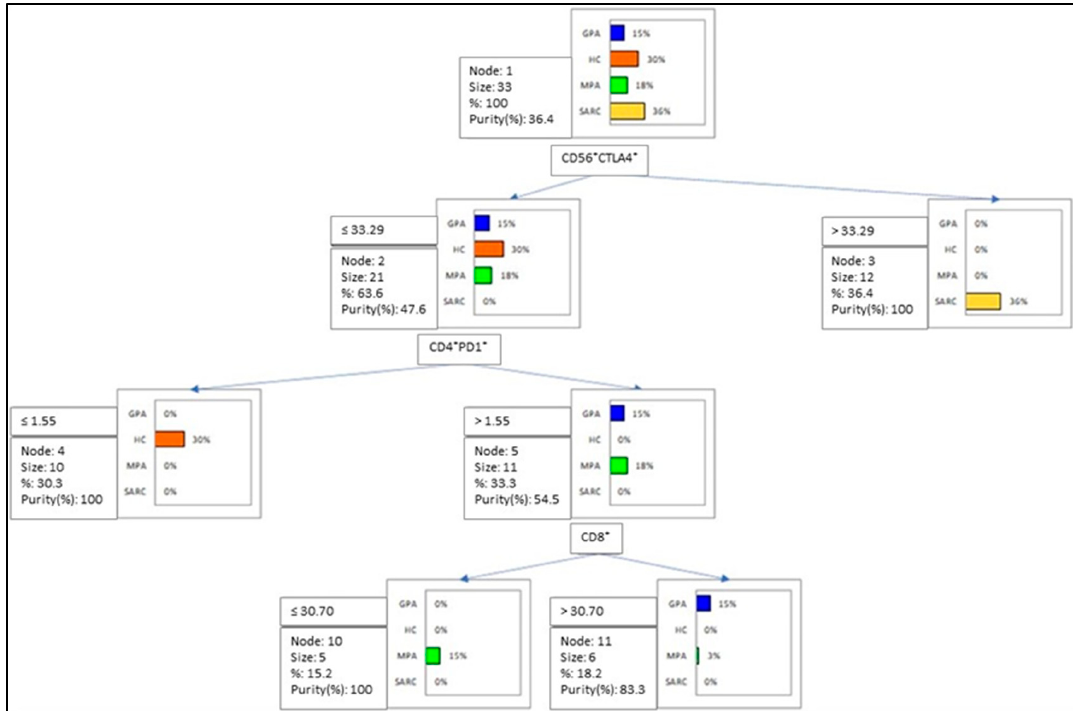
Figure 3. The decision tree model used to cluster the MPA, GPA, sarcoidosis and HC groups ac- cording to cut-off values of the cell percentages analyzed in this study. The model showed CD56 + CTLA4 + > 33.29% for 100% of sarcoidosis patients, but CD56 + CTLA4 + ≤ 33.29, CD4 + PD1 + > 1.55% and CD8 + > 30.7% for 100% of GPA patients. MPA patients (80%) were classified with CD56 + CTLA4 + ≤ 33.29, CD4 + PD1 + > 1.55% and CD8 + ≤ 30.7%, and the model showed CD56 + CTLA4 + ≤ 33.29 and CD4 + PD1 + ≤ 1.55% for 100% of healthy